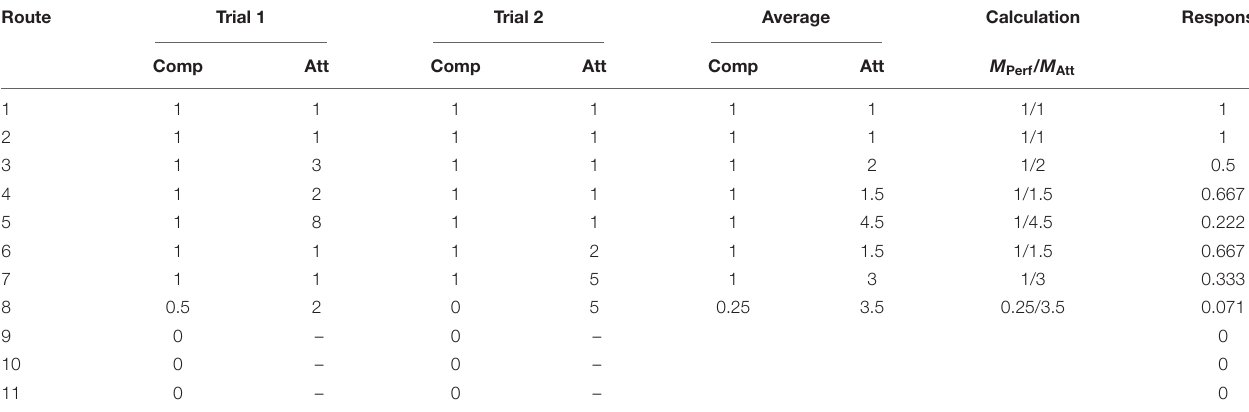
TABLE 2 | Full response calculation example. Route Trial 1 Trial 2 Average Calculation